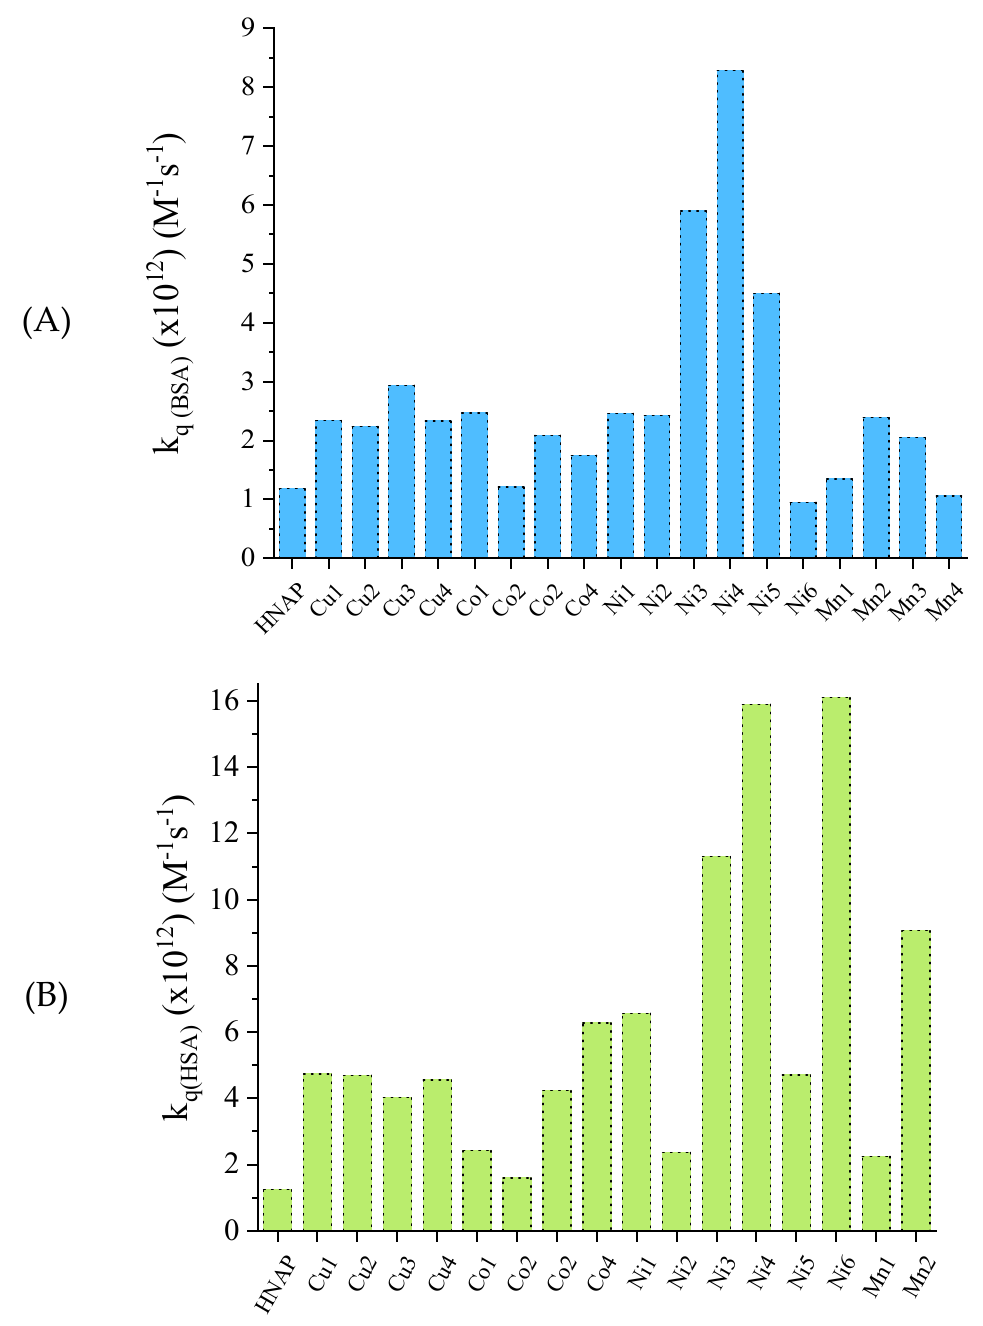
Figure 29. Albumin − quenching constants (k q ) for reported metal complexes. ( A ) For BSA. ( B ) For HSA. (Codes of compounds: HNAP = naproxen; Cu1 = [Cu 2 (NAP) 4 (H 2 O) 2 ]; Cu2 = [Cu(NAP) 2 (bipy)]; Cu3 = [Cu(NAP) 2 (phen)]; Cu4 = [Cu(NAP) 2 (py) 2 (H 2 O)]; Co1 = [Co(NAP) 2 (CH 3 OH) 4 ]; Co2 = [Co(NAP) 2 (py) 2 (H 2 O) 2 ]; Co3 = [Co(NAP) 2 (phen)(H 2 O) 2 ]; Co4 = [Co(NAP) 2 (bipy)(H 2 O) 2 ]; Ni1 = [Ni(NAP) 2 (CH 3 OH) 4 ]; Ni2 = [Ni(NAP) 2 (bipy)(CH 3 OH)]; Ni3 = [Ni(NAP) 2 (phen)(H 2 O)]; Ni4 = [Ni(NAP) 2 (bipyam)]; Mn1 = [Mn(NAP) 2 (CH 3 OH)] n ; Mn2 = [Mn(NAP) 2 (py) 2 (H 2 O) 2 ]; Mn3 = [Mn(NAP) 2 (phen)(H 2 O)] and Mn4 = [Mn 6 (NAP)(Hsal)(shi) 6 (py) 6